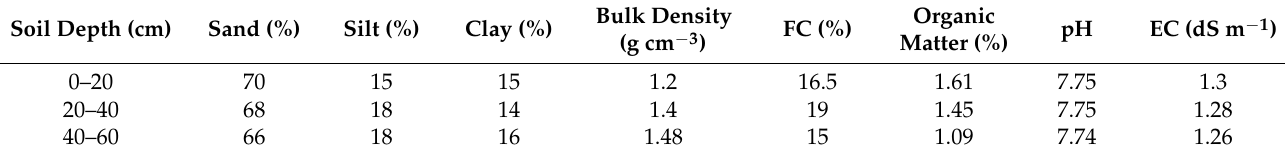
Table 5. Soil properties of different layers of the experimental